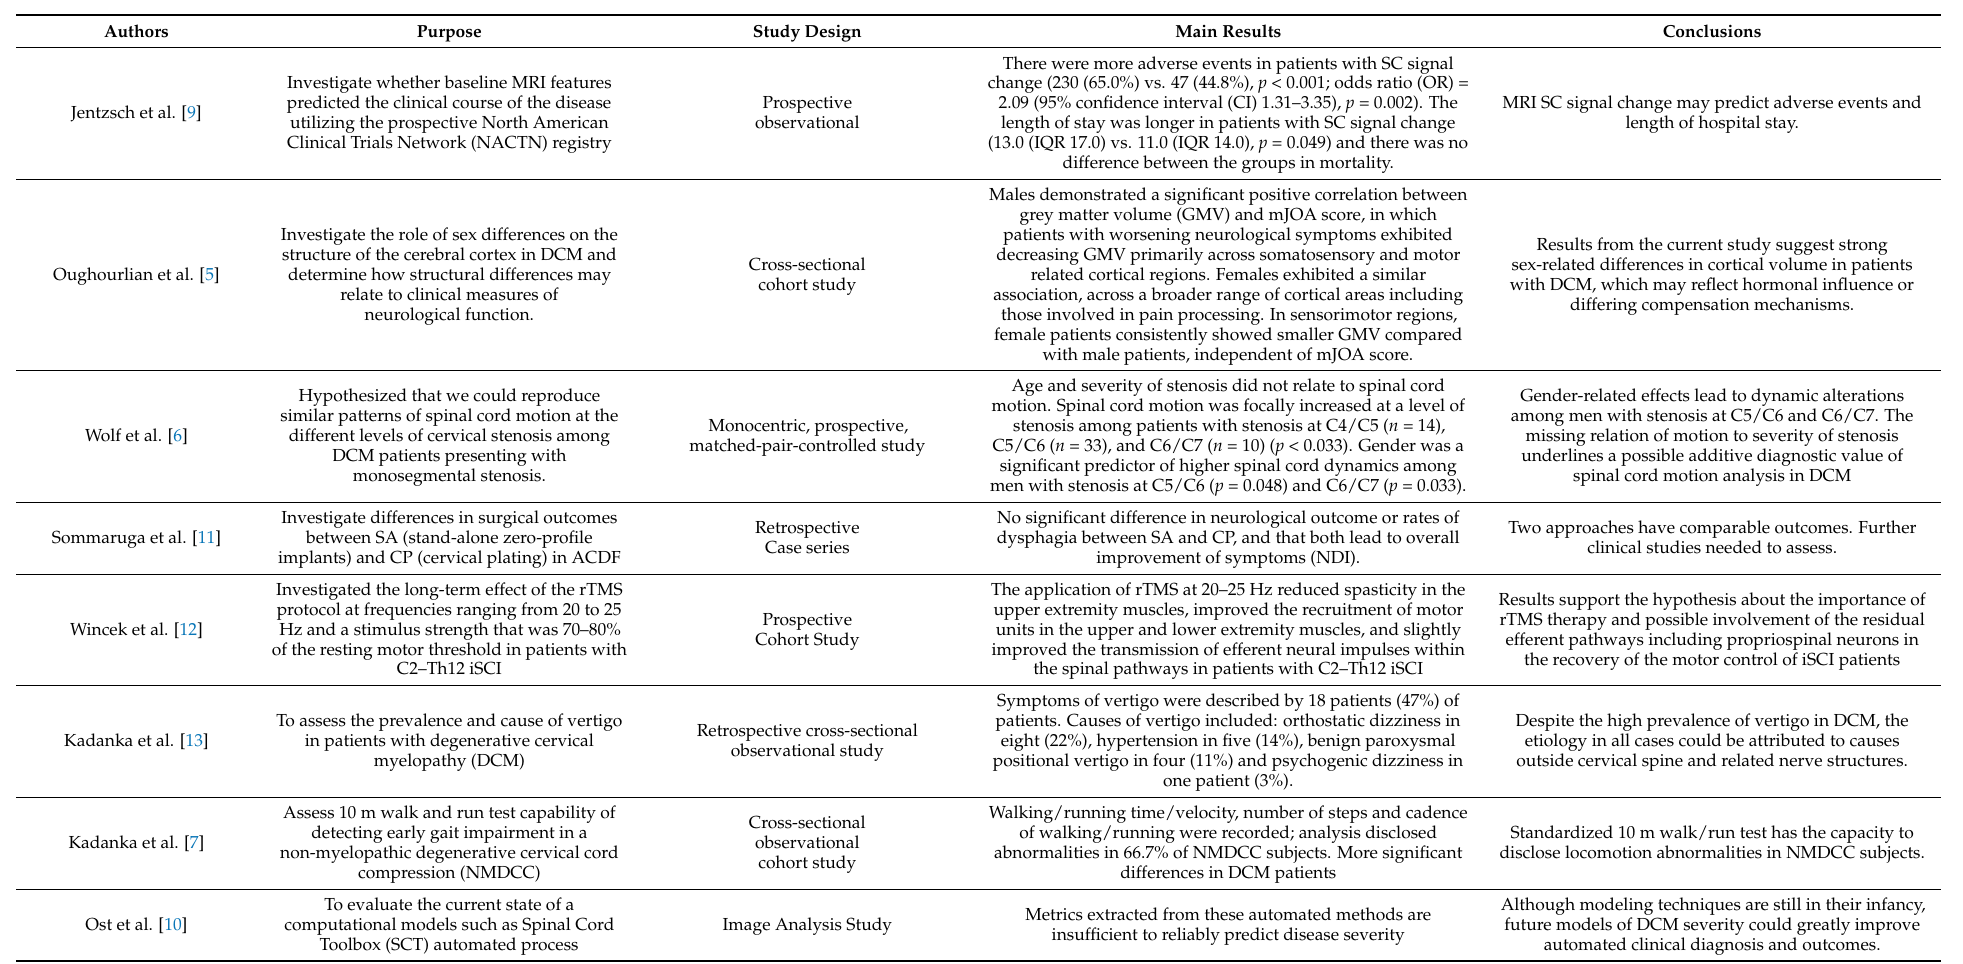
Table 1. Summary of published papers in this Special